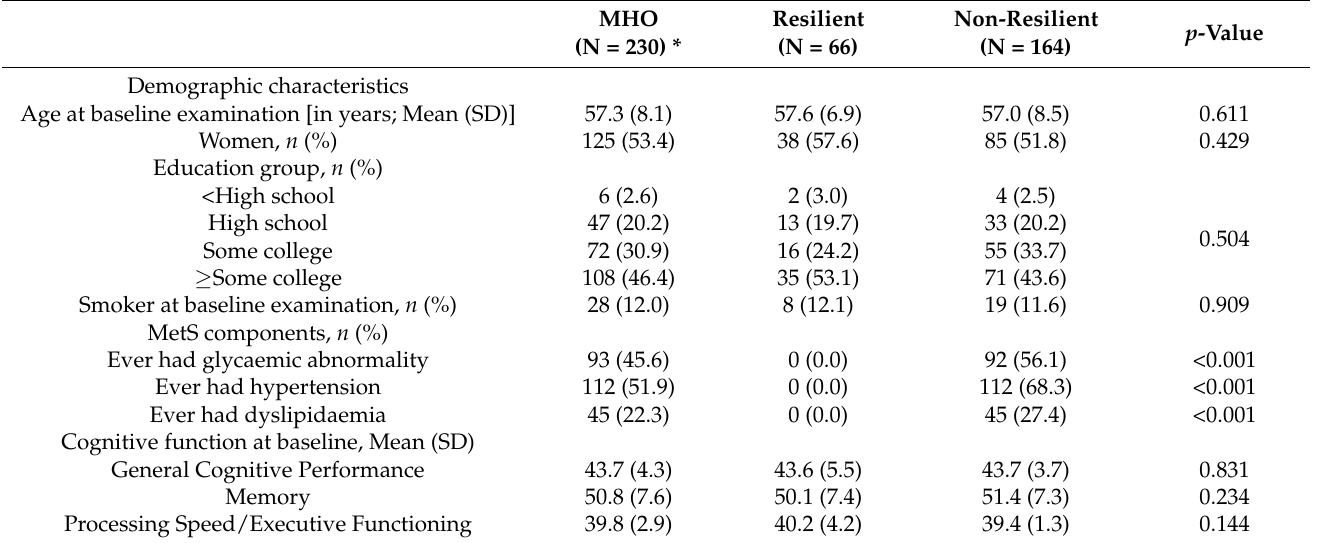
Table 2. Characteristics of the metabolically healthy overweight/obese participants (at baseline), both in total, as well as separately for those who remained resilient and for those who transitioned to an unhealthy metabolically health status.